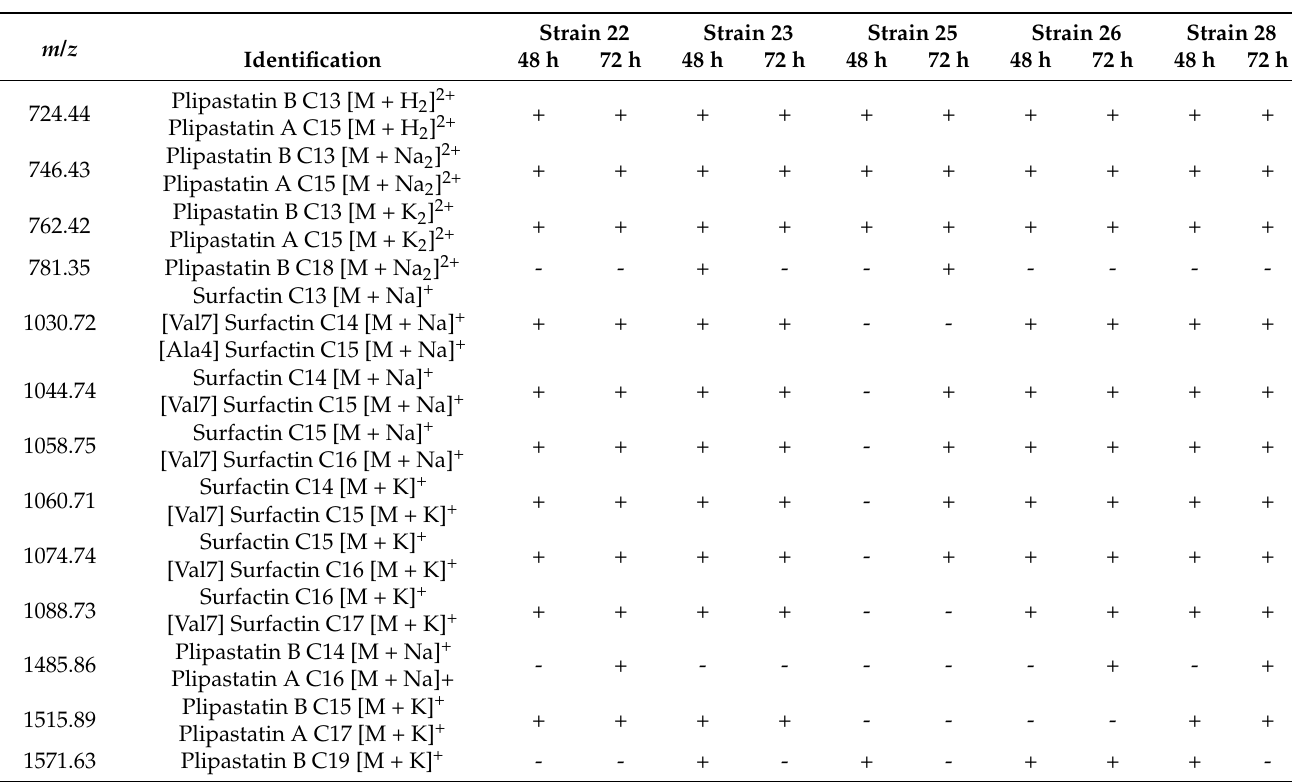
Table 2. Identification of lipopeptide signals present in the analysis by MALDI-TOF of the supernatant of samples of B. subtilis (strain 22, 23 26, 28) and B. tequilensis (strain 25) after 48 or 72 h